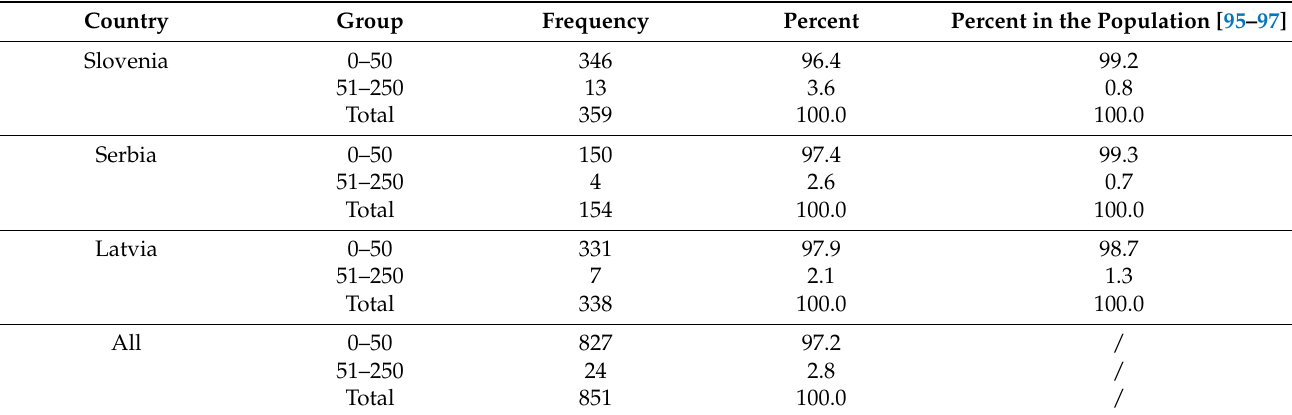
Table A4. Number of employees (full-time equivalent).